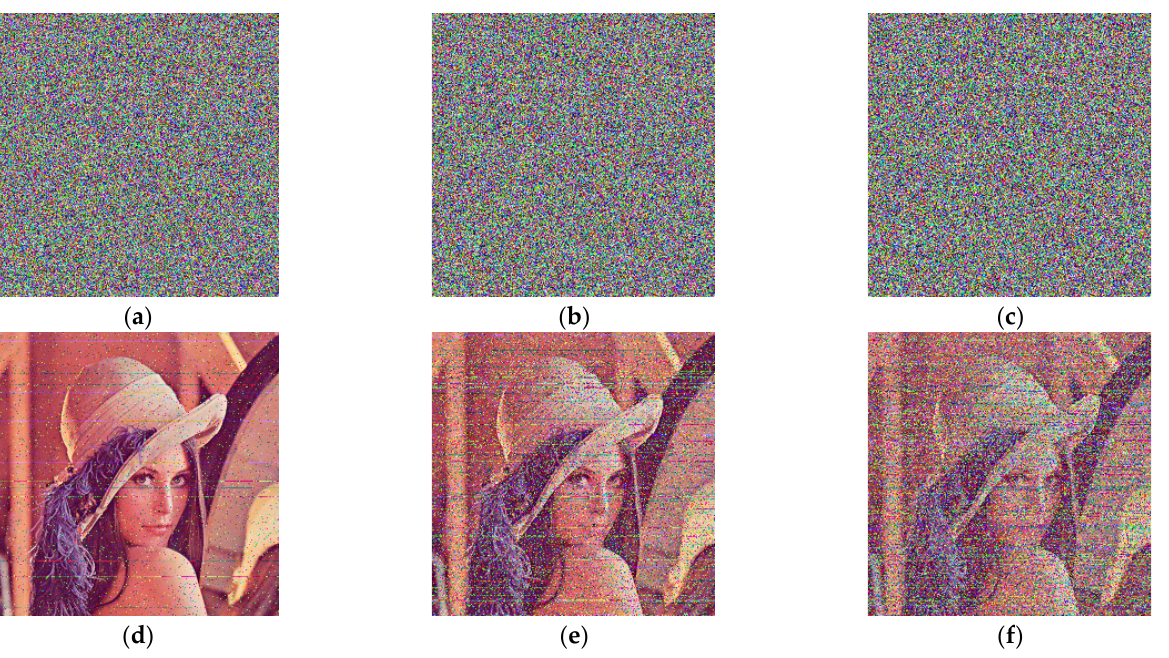
Figure 15. Salt & Pepper noise test, ( a , d ) noise density: 0.01, ( a , d ) noise density: 0.05, ( c , f ) noise density: 0.1.